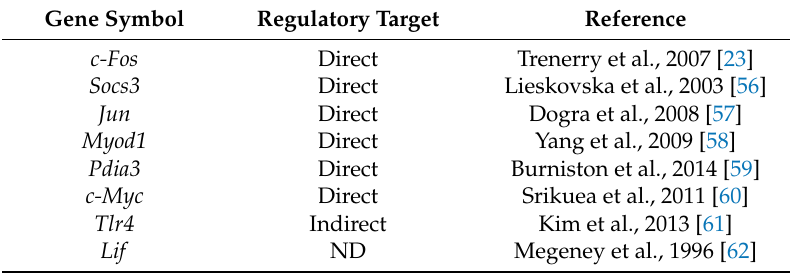
Table 1. List of genes that are directly or indirectly regulated by STAT3. This table was generated by integrating data from seven genome-wide studies of direct target genes of STAT3 by microarray, ChIP or ChIP-Seq [44,50–55]. The resulting list was then cross referenced with the literatures to identify the genes that were experimentally proven to be directly or indirectly regulated by STAT3 in the skeletal muscle. ND: not